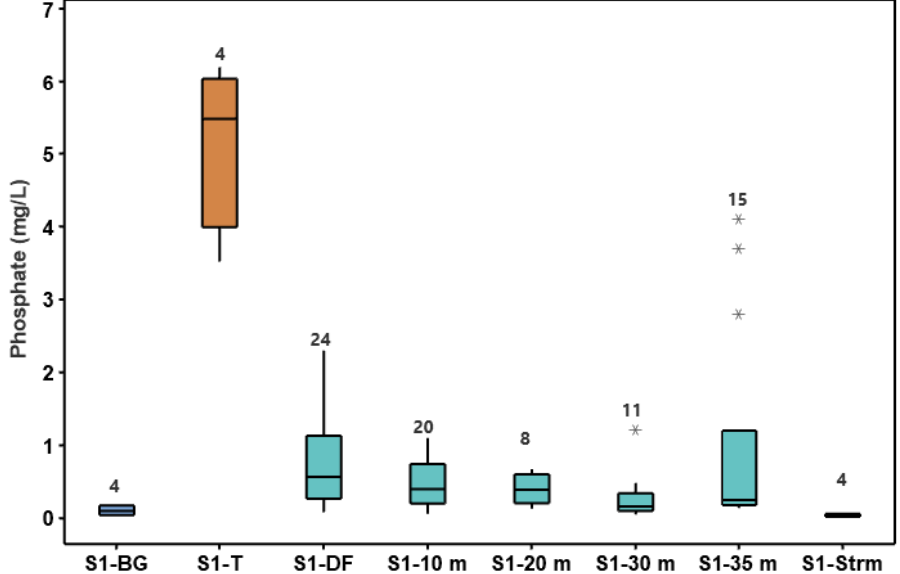
Figure 6. Phosphate concentrations in wastewater sampled from the septic tank (T), groundwater near the drainfield trenches (DF), groundwater 10 to 35 m downgradient from the trenches, in background groundwater (BG), and the adjacent stream at Site 1 (S1). Vertical lines extending from the boxes show minimum and maximum values. Statistical outliers are shown as (*). Number of samples is shown above each box.